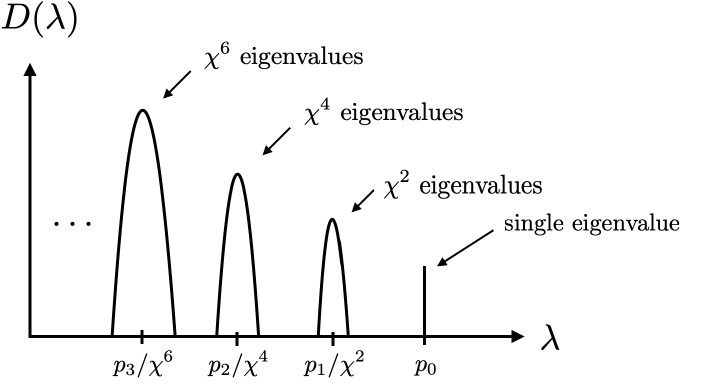
(if q 1 ) or p (if q 1 ). 0 AB < 1 AB >